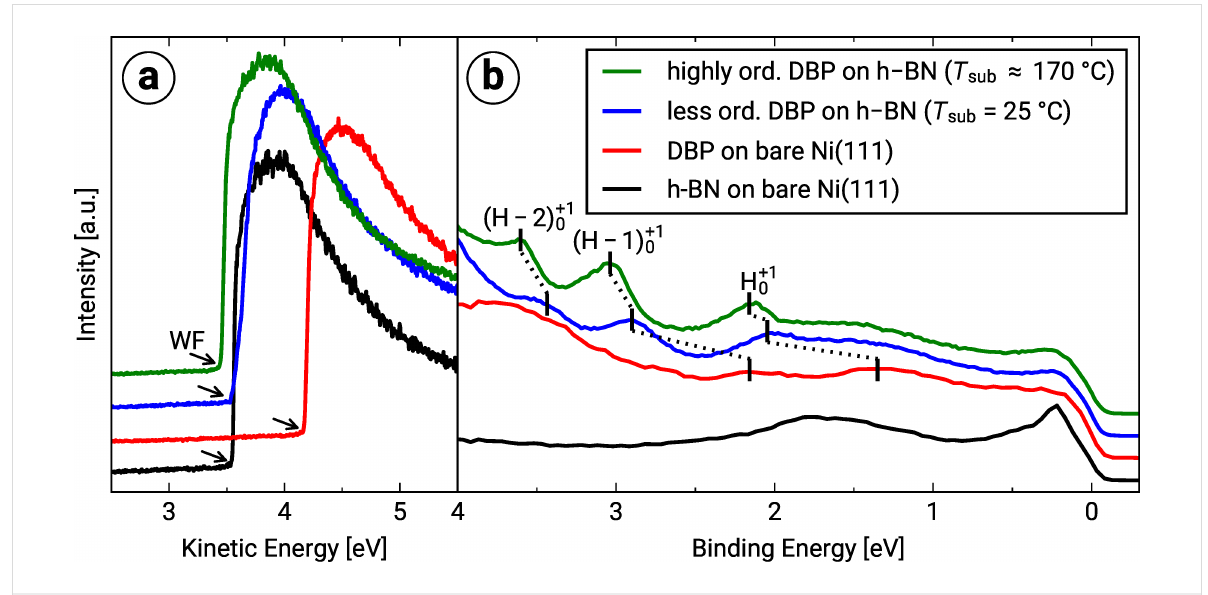
Figure 4: (a) Secondary electron cut-off (SECO) of DBP on bare Ni(111) (approx. 1.0 MLE), on h-BN/Ni(111) (less ordered (approx. 1.0 MLE) and highly ordered (approx. 1.6 MLE)), and of bare h-BN/Ni(111). The kinetic energy onset of the SECO, which corresponds to the work function is marked by black arrows. (b) Corresponding ultraviolet photoelectron spectra at a polar angle of 70°. The positions of the HOMO ( ), HOMO-1 ( ) and HOMO-2 ( ) are marked by vertical black